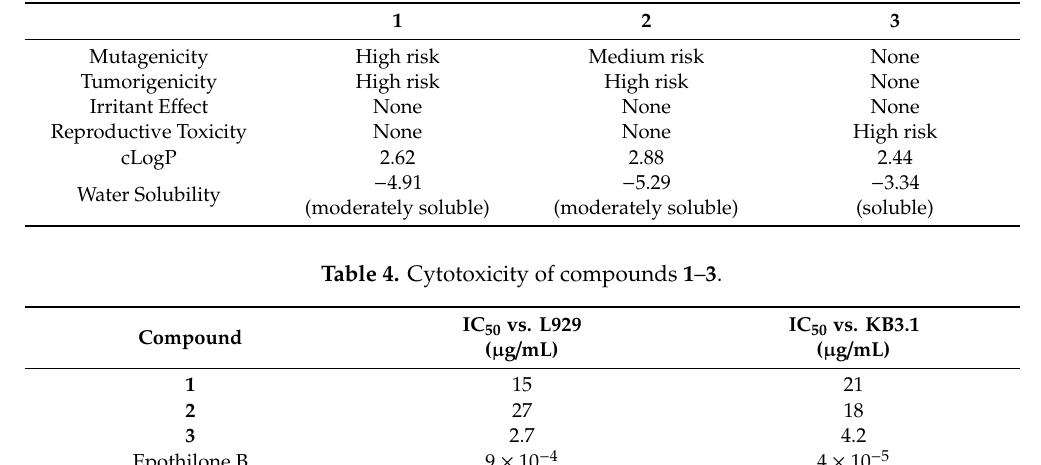
Table 4. Cytotoxicity of compounds 1 – 3 .